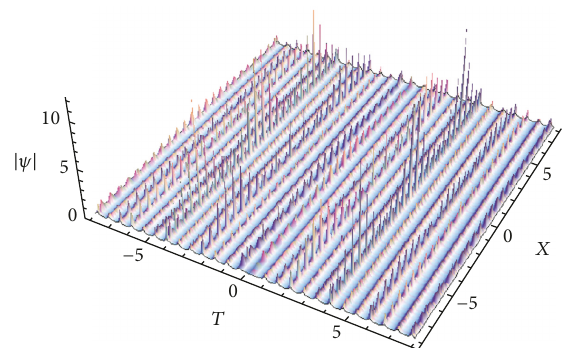
Figure 14: Spatial structure of the module of solution (81) with 𝑘 = 5